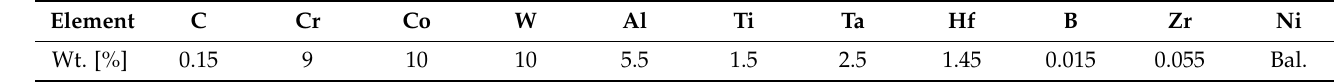
Table 1. Chemical compositions of K4002 nickel-based special alloy.